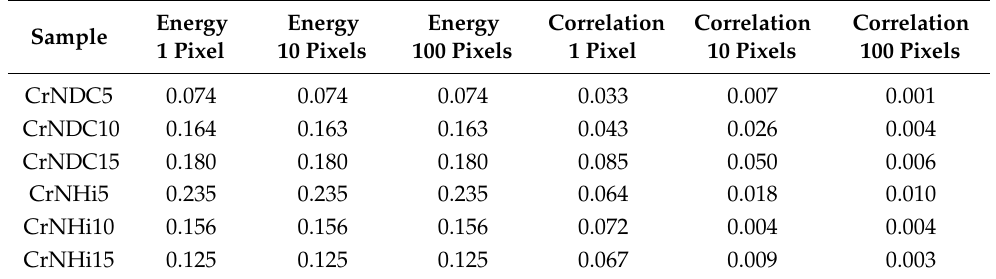
Table 3. Energy and correlation of the surface morphology GLCM matrix for different pixel distances.